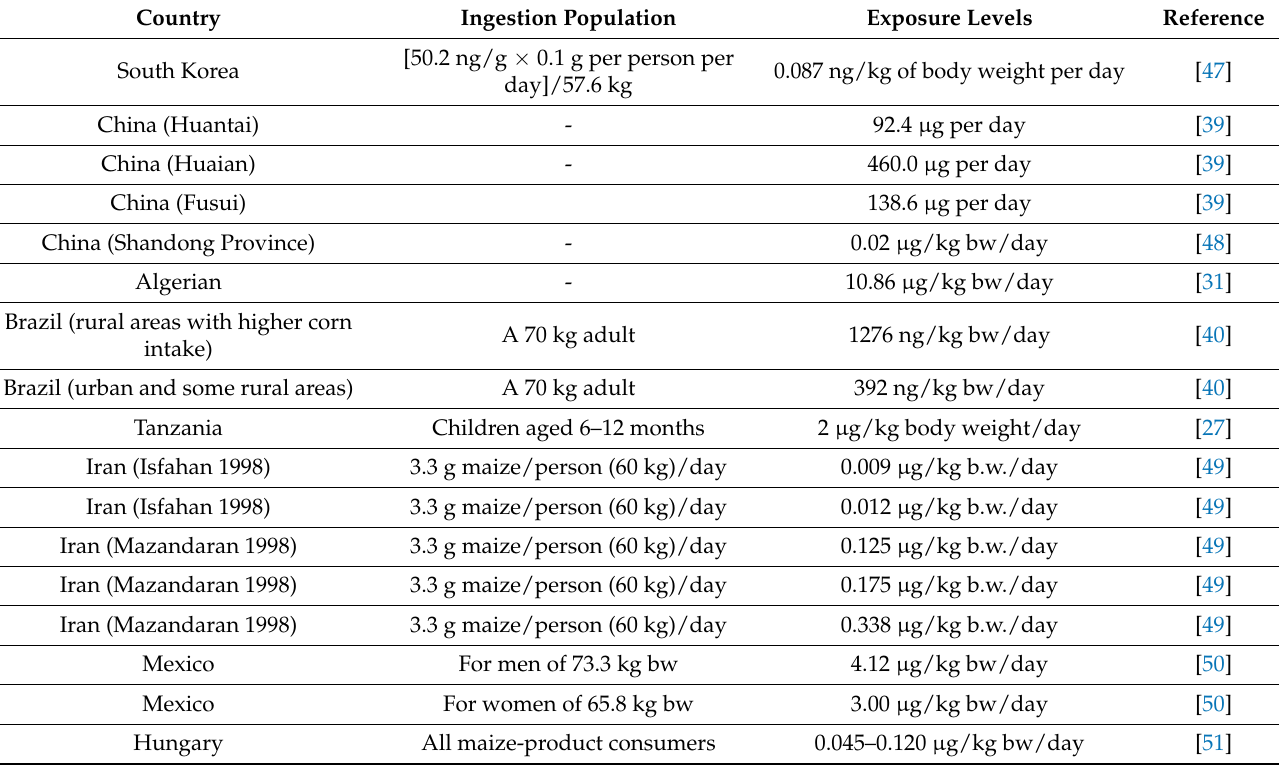
Table 3. FB1 exposure levels in people from different